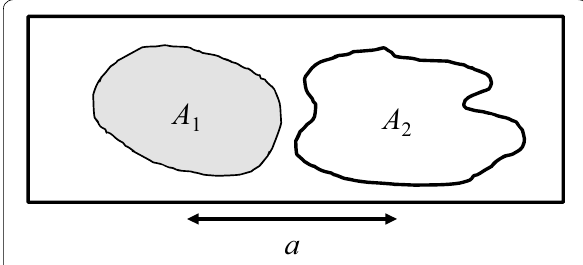
Fig. 1 Sketch of the fault model. An asperity with area A 1 and a weak region with area A 2 are shown. The rectangular frame is the fault border. The state of the fault is described by the slip deficits x ( t ) and y ( t ) of the two